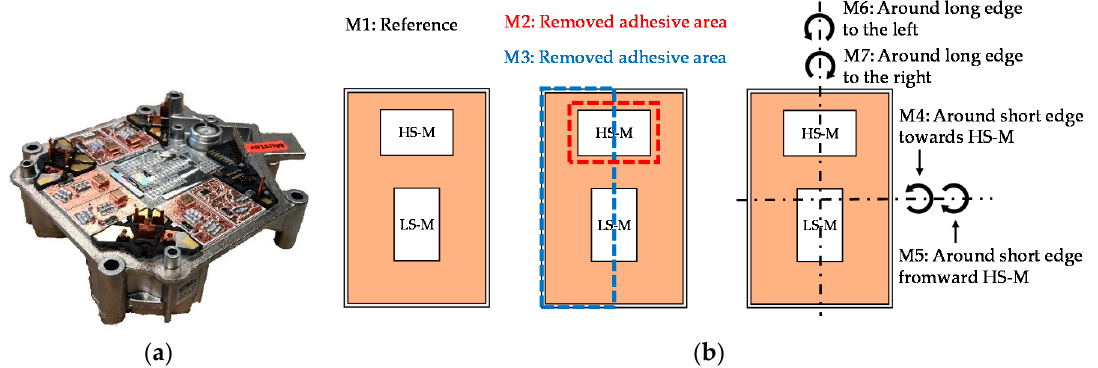
Figure 9. ( a ) Image of the inspected power inverter module in a semi-fabricated state for adhesive investigation with five half bridges on five DBCs attached with nonconductive thermal adhesive to an aluminum body. The sixth DBC holds peripheric components. ( b ) Schematic description of adhesive manipulations on a single DBC / half bridge used for grouping.